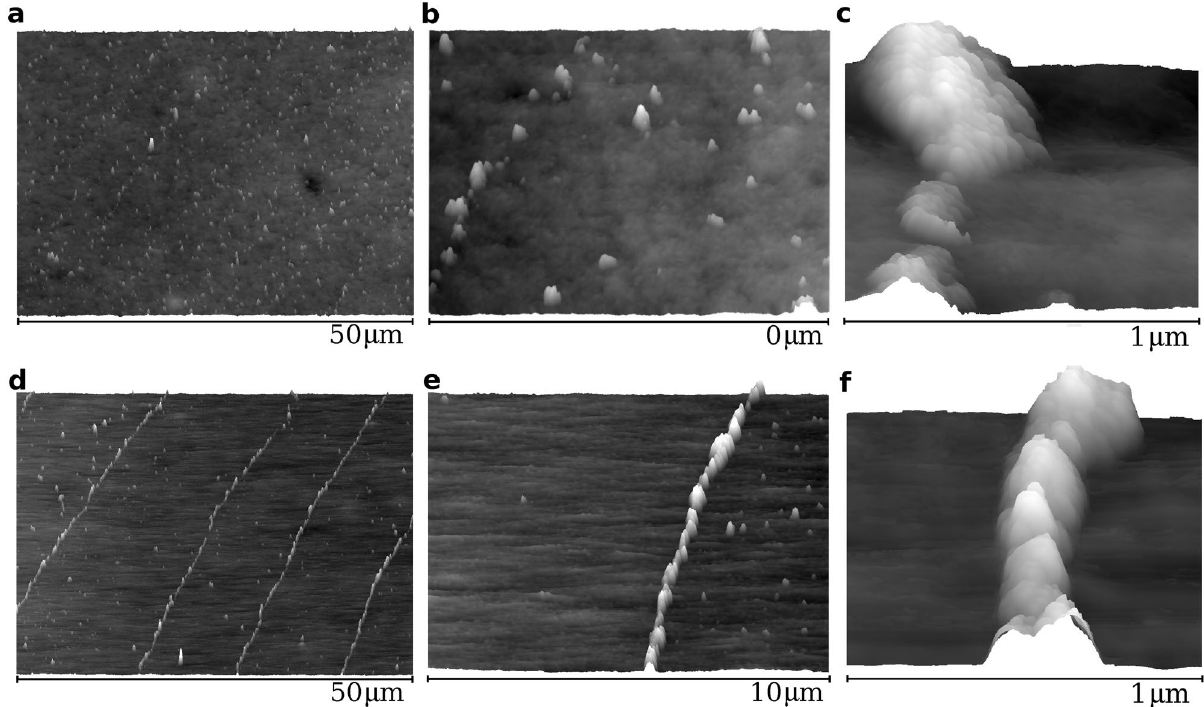
Figure 2. AFM topography of the representative fragments of the magnetic liquid droplet deposit on LDPE film. ( a – c ) deposit on pristine LDPE. ( d – f ) Deposit on stretched LDPE. In both types of LDPE, the average deposit height in panel ( c ) and ( f ) is about 60